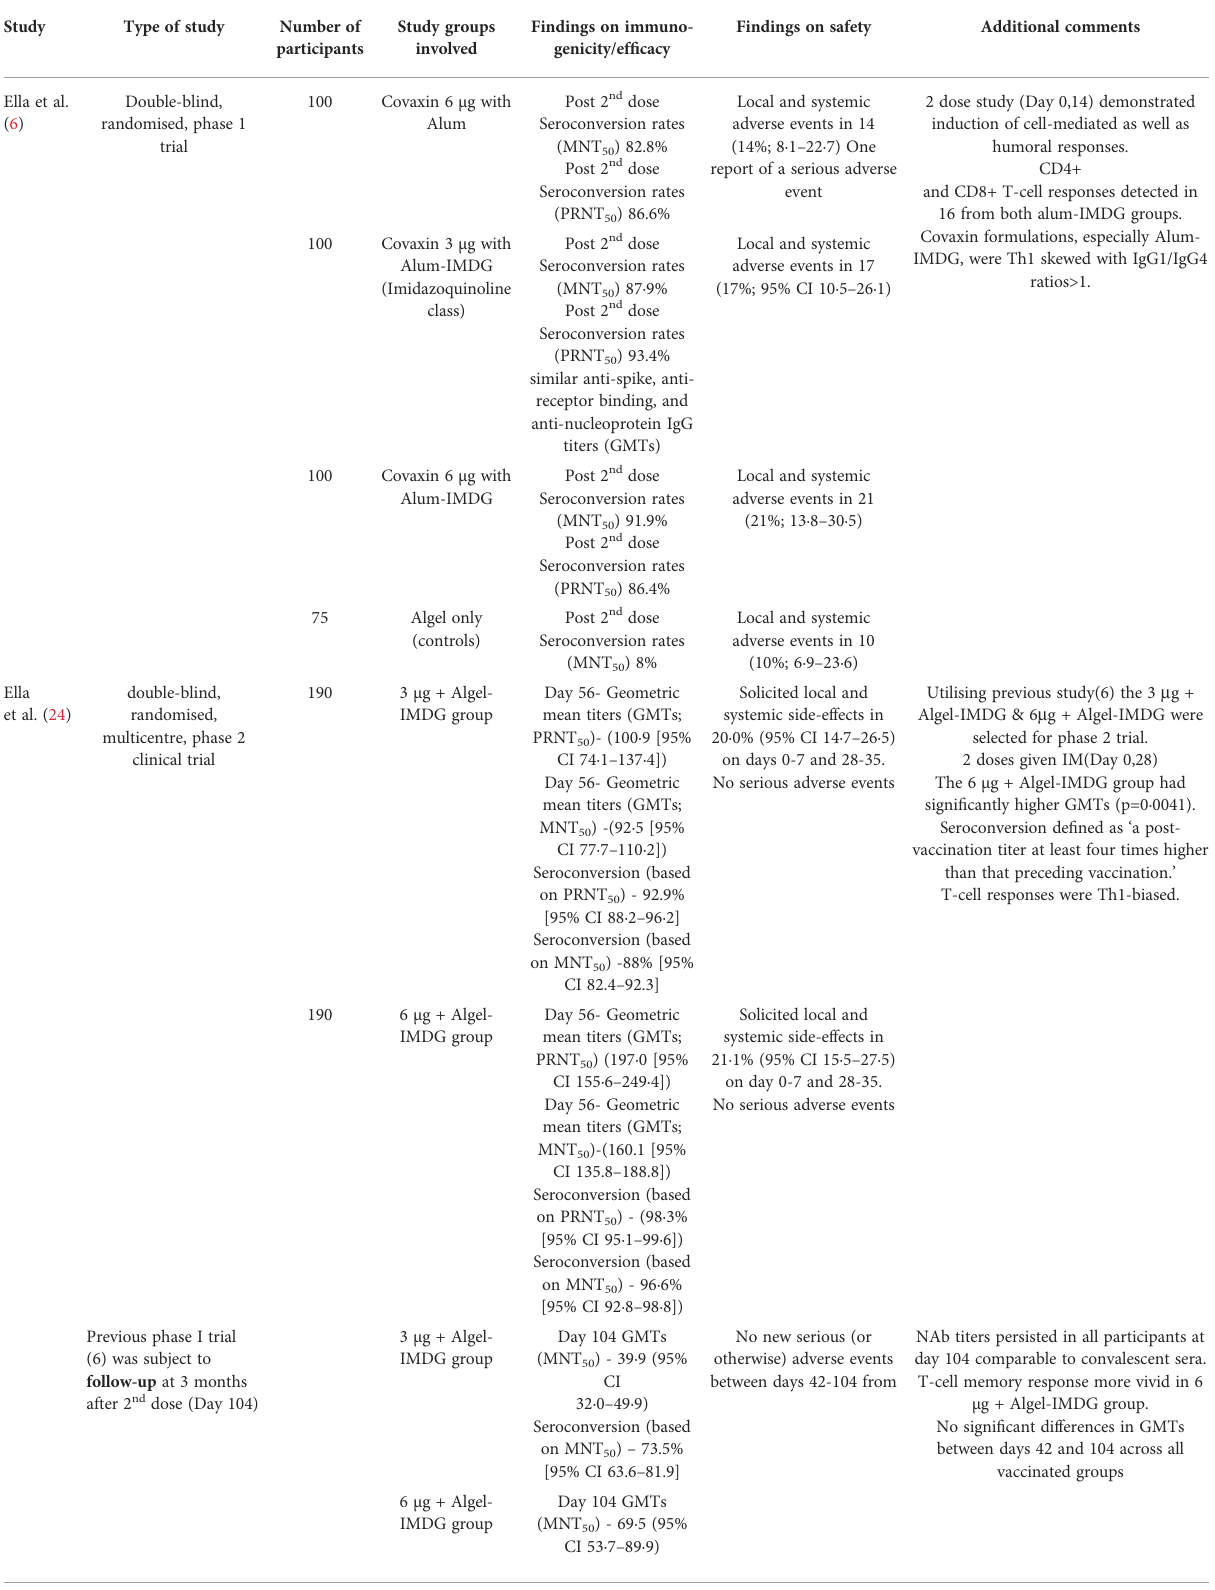
TABLE 1 Phase I, II & III trials on the